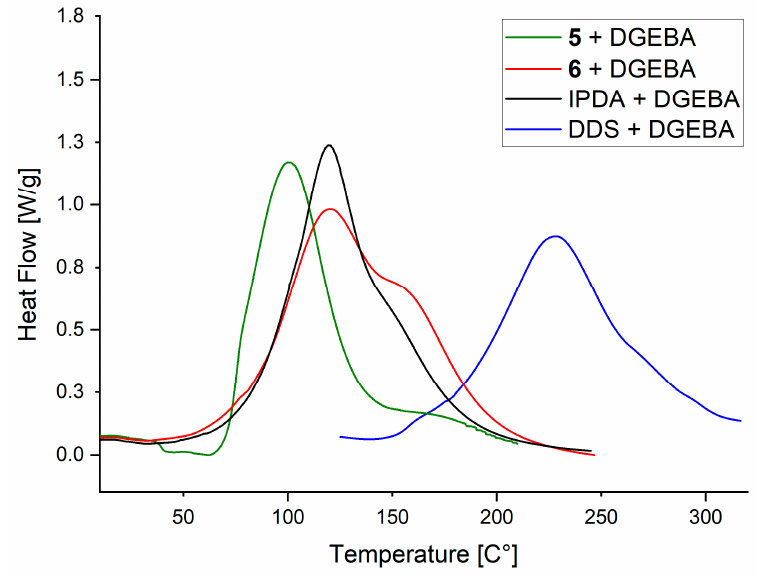
Figure 3. DSC thermograms of hardeners 1 , 2 , IPDA, and DDS during curing with DGEBA. Table 1. Onset temperatures of the curing reaction and the glass transition temperatures (T g ) of the polymers formed by the investigated amines with